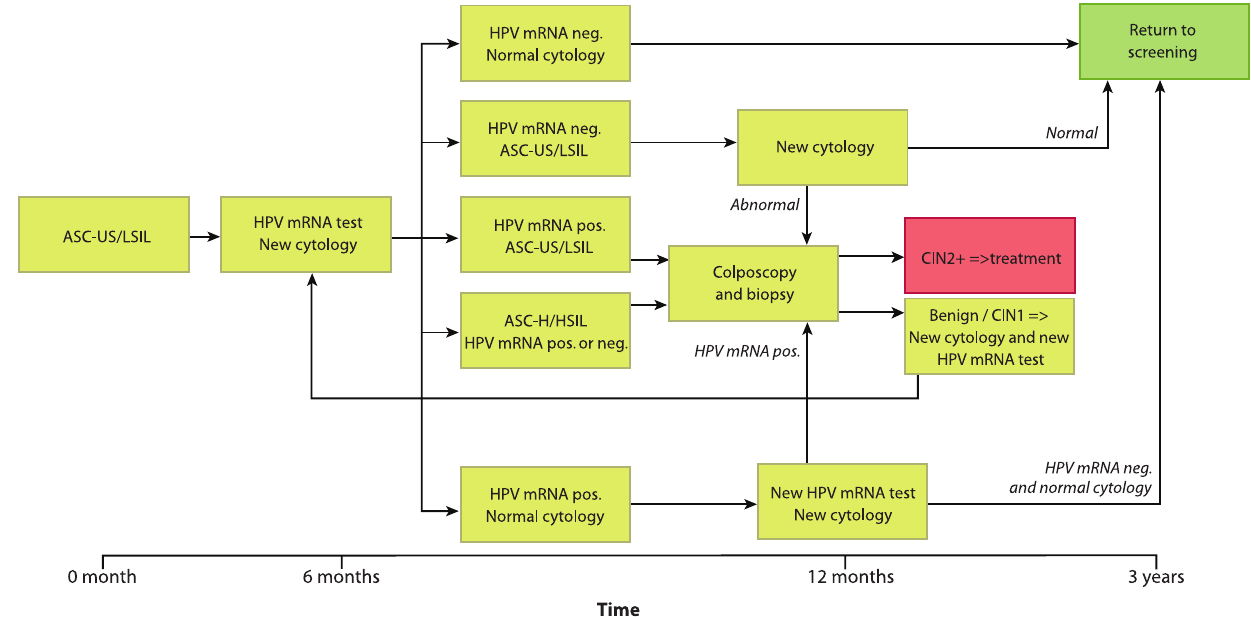
Figure 1. Flow chart showing the guidelines for HPV E6/E7 mRNA testing. Women with ASC-US or LSIL at triage and with a positive HPV result are referred to colposcopy and biopsy; if the HPV test is negative, the woman is referred to a third Pap-smear after one year. Women with normal cytology and a positive HPV mRNA result at triage are recommended to have a third Pap-smear and a new HPV mRNA test after 6 months; women with a persistent HPV mRNA result are referred to colposcopy and biopsy. Women with ASC-H and HSIL at triage are referred directly to histological investigation regardless of HPV status.